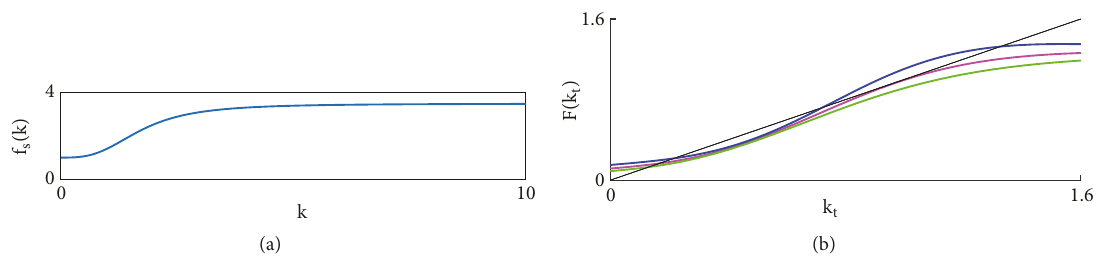
Figure 1: (a) Production function 𝑓 𝑠 (𝑘 𝑡 ) for 𝛼 = .5 , 𝛽 = .2 , 𝜌 = 3 , and 𝑐 = 1 . (b) Map 𝐹(𝑘 𝑡 ) and its fixed points for 𝑛 = 𝑠 𝑤 = .2 , 𝛿 = 𝑠 𝑟 = .7 , 𝛼 = 1 , 𝛽 = .5 , and 𝑐 = 𝛼(𝜌 − 1) 2 /4𝛽𝜌 ; one fixed point for 𝜌 = 2.5 (green map), two fixed points for 𝜌 = 2.8 (purple map), and three fixed points for 𝜌 = 3.2 (blue